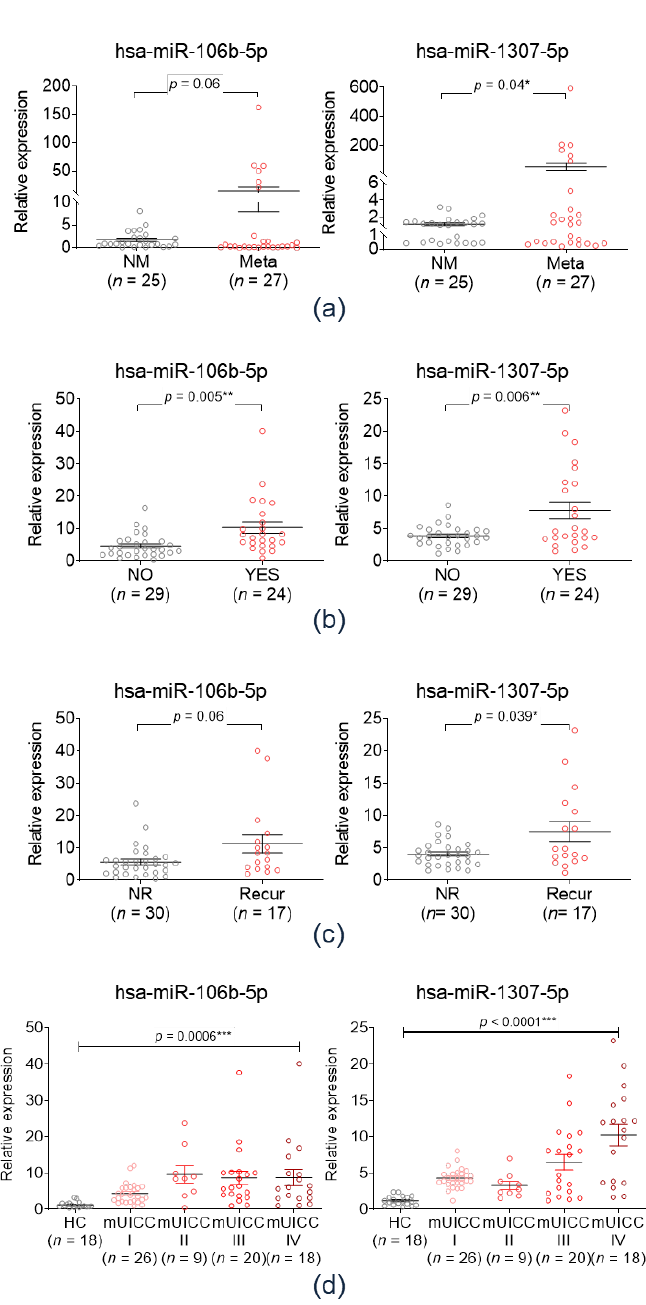
Figure 4. Validation of the clinical implications of candidate exo-miRs in the validation cohort. ( a ) Expression of two plasma exo-miRs in the metastasis-free group (NM, n = 27) and the metastasis group (Meta, n = 25). * p < 0.05. ( b ) Expression of the serum exo-miRs according to the vascular invasion status. * p < 0.05; ** p < 0.01. ( c ) Expression of serum exo-miRs according to the recurrence status. ( d ) Expression of the serum exo-miRs according to the modified UICC stage. *** p < 0.001. NM, non-metastasis; Meta, metastasis; UICC, Union for International Cancer